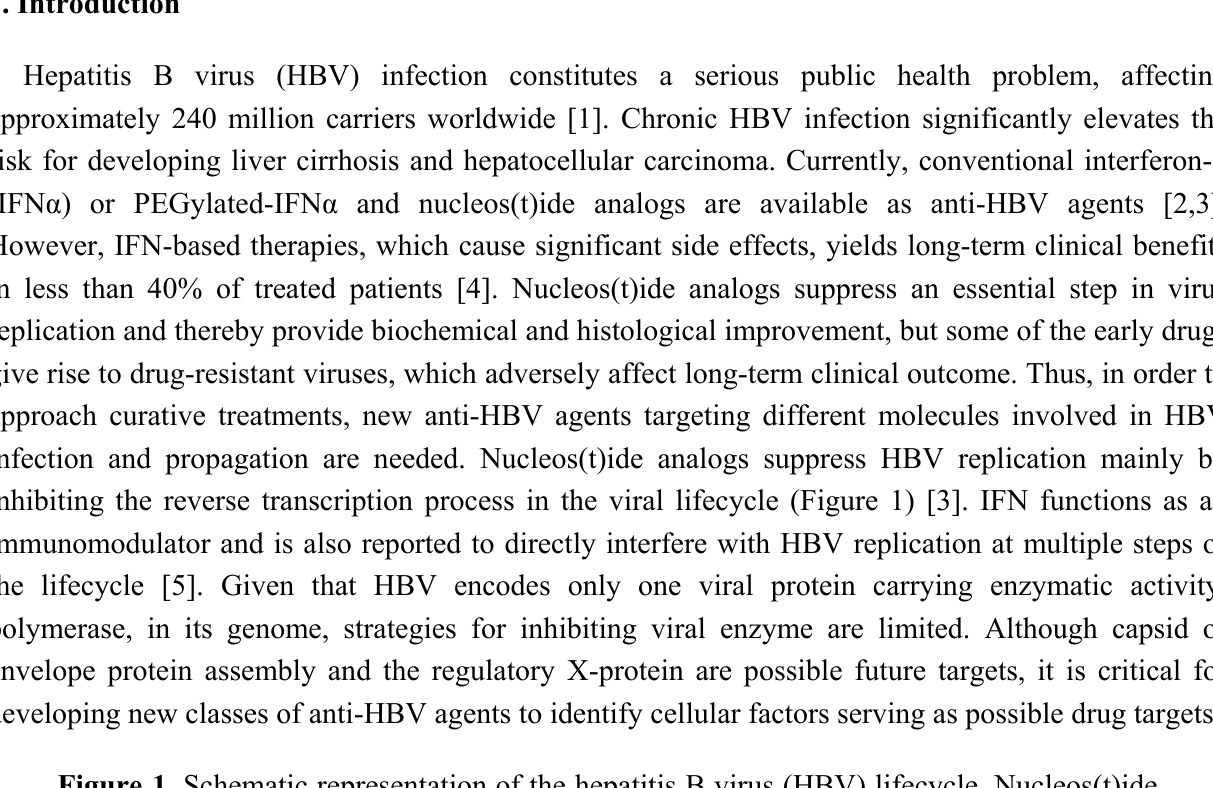
Figure 1. Schematic representation of the hepatitis B virus (HBV) lifecycle. Nucleos(t)ide analogs inhibit reverse transcription. Myrcludex-B, cyclosporin A and some NTCP inhibitors can inhibit the viral entry process by targeting